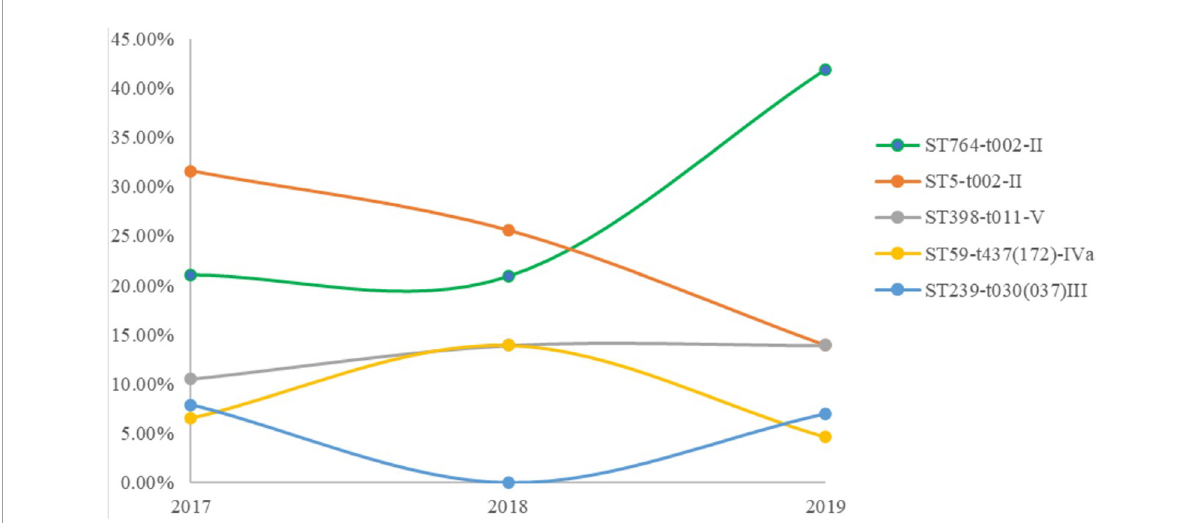
FIGURE1 Minimal spanning tree based on multilocus sequence typing (MLST) of methicillin-resistant Staphylococcus aureus (MRSA) isolates. All 14 STs are represented by a circle with color. Non-typeable isolates were excluded.